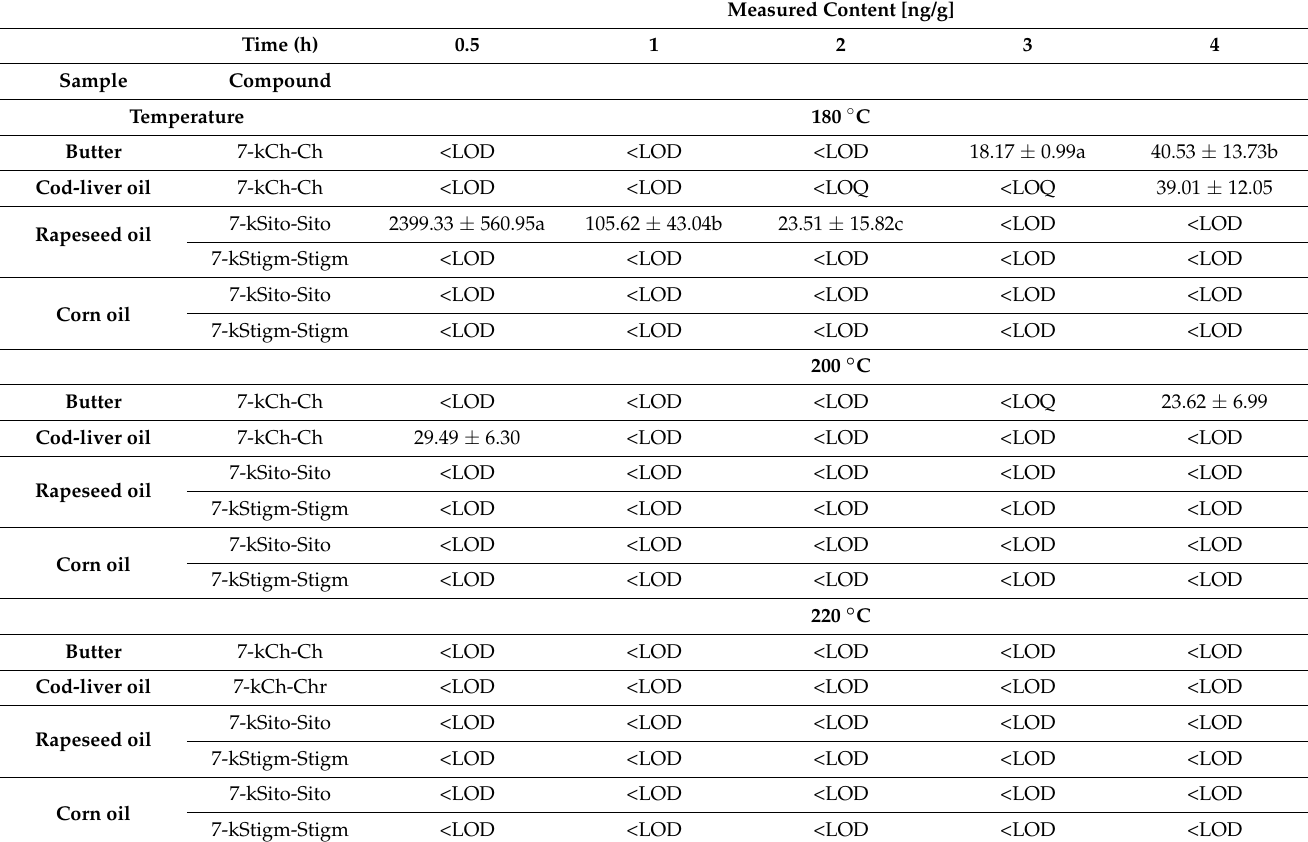
Table 2. Measured content of oxidized 3 β ,3 (cid:48) β -disteryl ethers in chosen biological samples. Measured Content